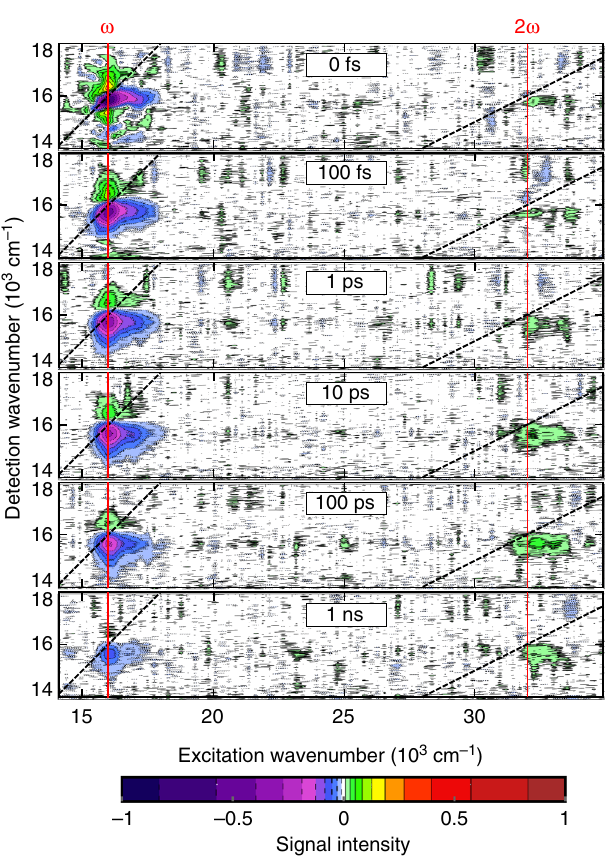
Fig. 4 Two-dimensional spectra of MEH-PBI aggregates. The conventional absorptive 2D spectrum occurs near the maximum of the laser spectrum at 16,000 cm − 1 (red vertical line labeled as ω ) and the EEI2D spectrum near 32,000 cm − 1 (red vertical line labeled as 2 ω ). The spectra are shown for several population times as indicated. Excitation pulse energy was set to 10 nJ. Contours are drawn at fractions of 0.01, 0.03, 0.05, 0.08, 0.13, 0.19, 0.27, 0.4, 0.57, and 0.83 of the maximal signal amplitude. To stress the connection with transient absorption, we employ the same sign convention and plot a decrease of absorption as negative and an increase as positive negative peak located slightly below the spectral diagonal (black dashed) combines ground-state bleach and stimulated emission.